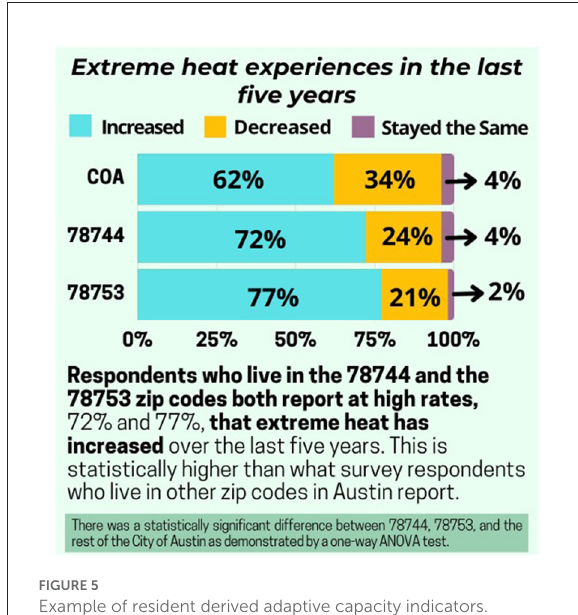
FIGURE5 Example of resident derived adaptive capacity